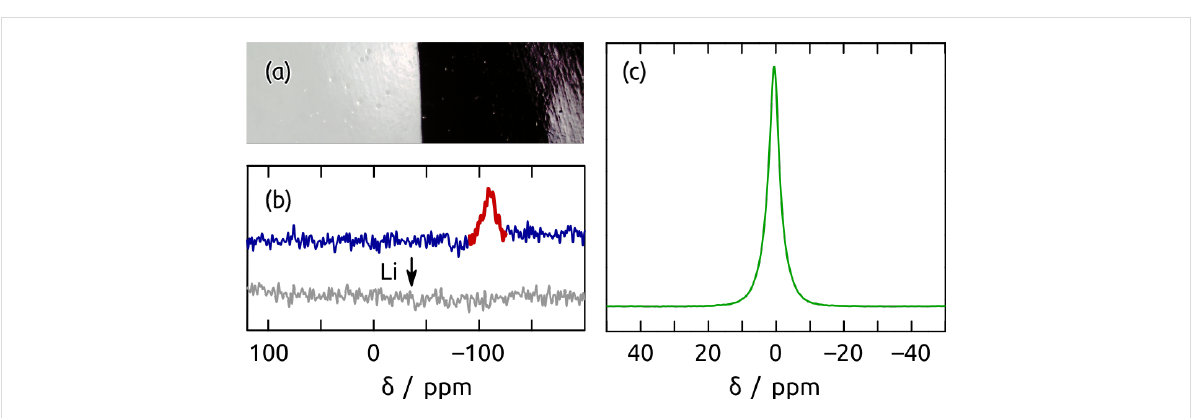
Figure 5: (a) Photograph of two nanoporous samples before and after the reduction by Li vapor with the subsequent acidic treatment (left and right, respectively). (b) 29 Si MAS NMR spectra before and after reduction. (c) 7 Li MAS NMR spectrum after reduction.